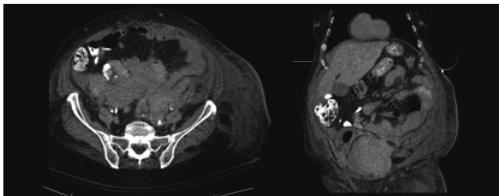
Figure 4: CT rectus sheath hematoma (Case 2)—a large retroperi- toneal hematoma in the right posterior pararenal space, with an associated intramuscular hematoma in the right iliacus and right psoas muscle.